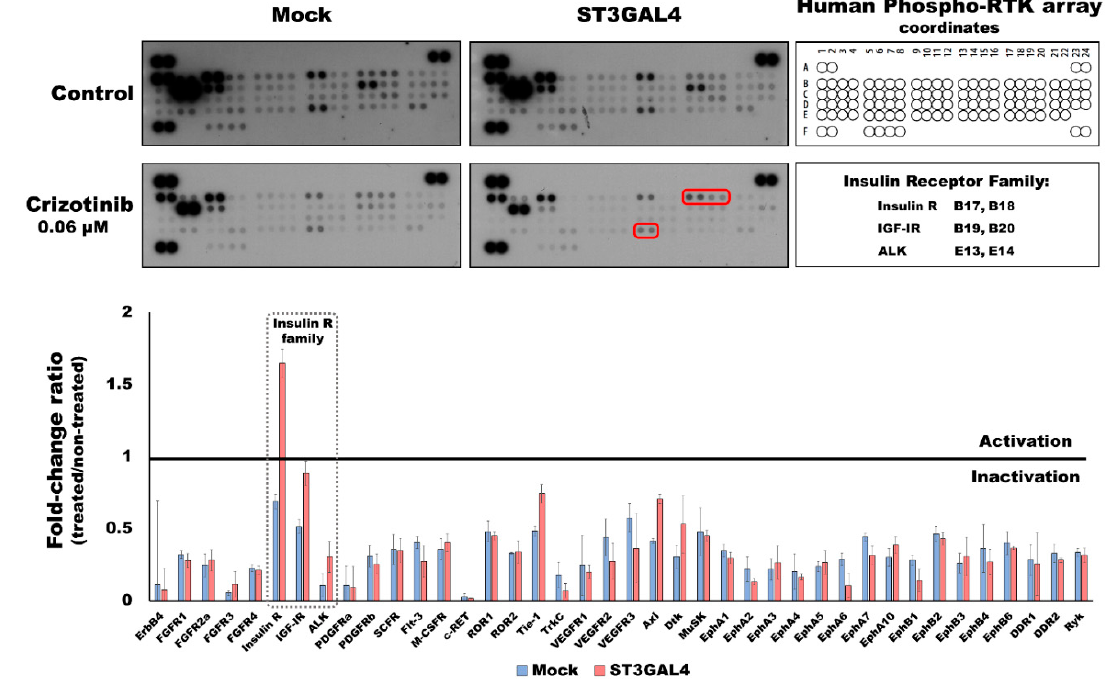
Figure 4. Insulin receptor is activated in ST3GAL4 cell model after treatment with crizotinib. Gastric MCTS were generated using the 3D Petri Dish ® technology (MICROTISSUES ® ) plates for 5 days and treated with 0.06 µ M of crizotinib for 48 h. 300 µ g of protein lysate of mock and ST3GAL4 were subjected to phopho-receptor tyrosine kinases (RTK) arrays. The optical density signal was quantified only in non-saturated spots and measured in duplicates. Upper-left corner spots were not quantified due to overlapping signal. Insulin receptor family members are framed in red and dashed squares.